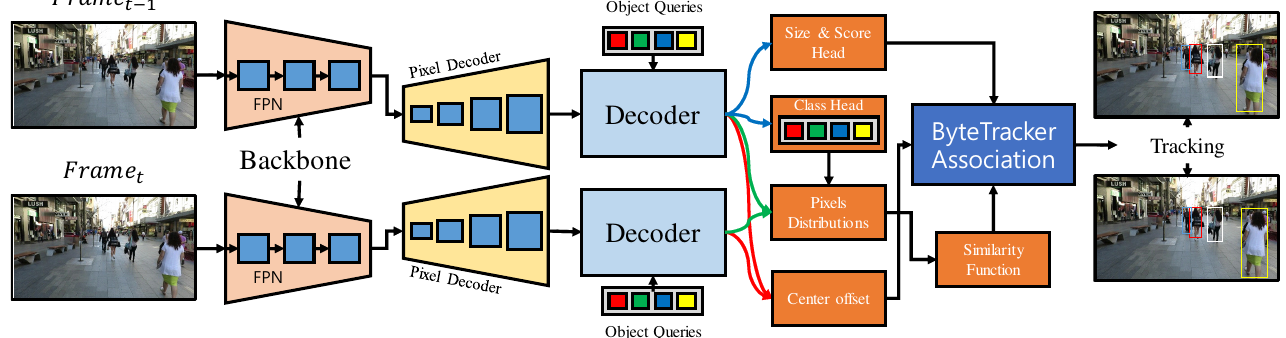
Figure 1. Our proposed architecture. The shared backbone is used to generate multi-scale feature embeddings. An encoder generates memory of frame multi-scale features I t − 1 and queues it to the decoder of I t 0 . The encoder and decoder consist of multi-head self-attention layers, cross-attentions, and feed-forward networks. The pixel distribution between I t − 1 and I t 0 of decoder memory is generated to compute the similarity matrix. The similarity matrix is then integrated with state-of-the- art ByteTrack [23] association framework, Finally, the bounding box, class score, and center offset are generated using multi-layer perception heads. Blue arrows indicate the current frame bounding box, size, and class score. Red and green arrows indicate the consecutive frame features used for the reid